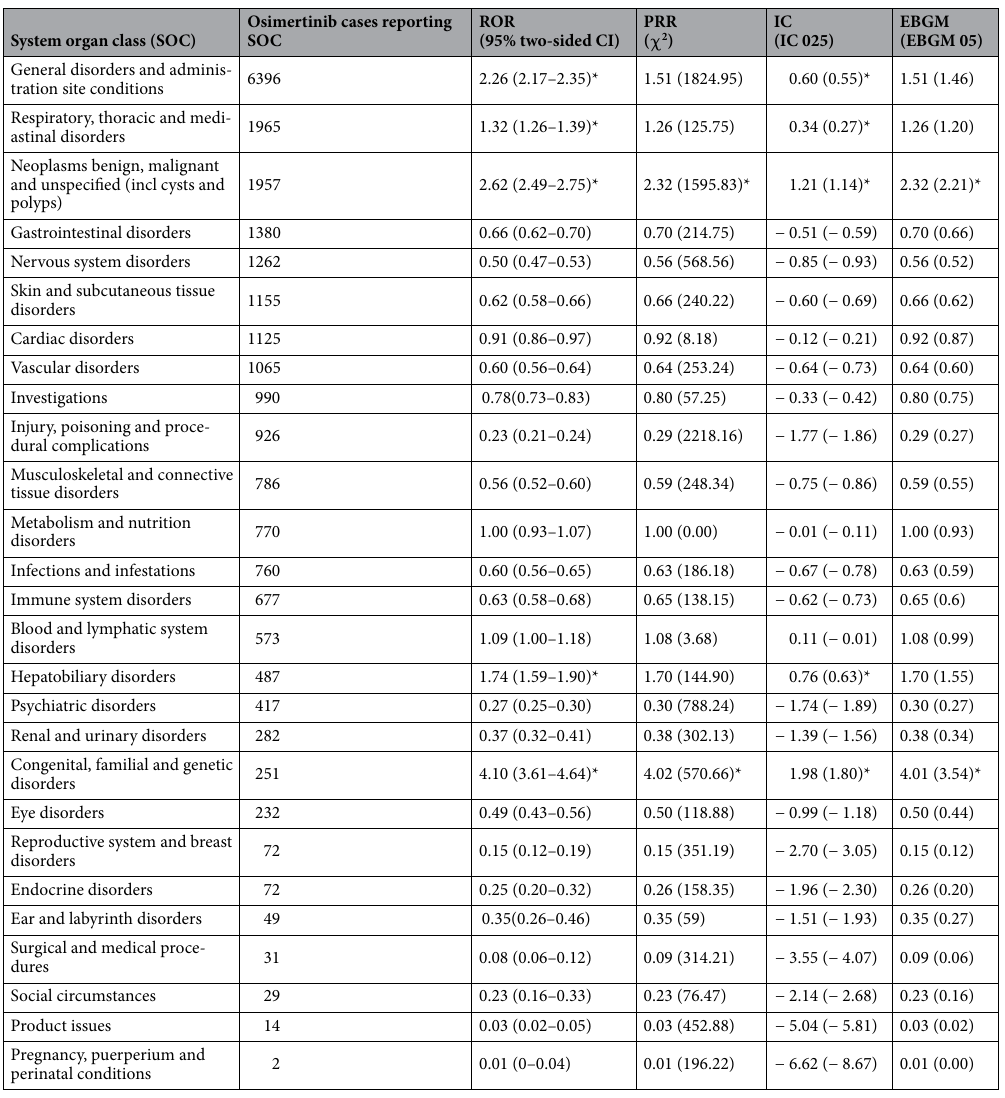
information component, IC 025 the lower limit of 95% CI of the IC, EBGM empirical Bayesian geometric mean, EBGM 05 the lower limit of 95% CI of EBGM. *Indicates statistically significant signals in